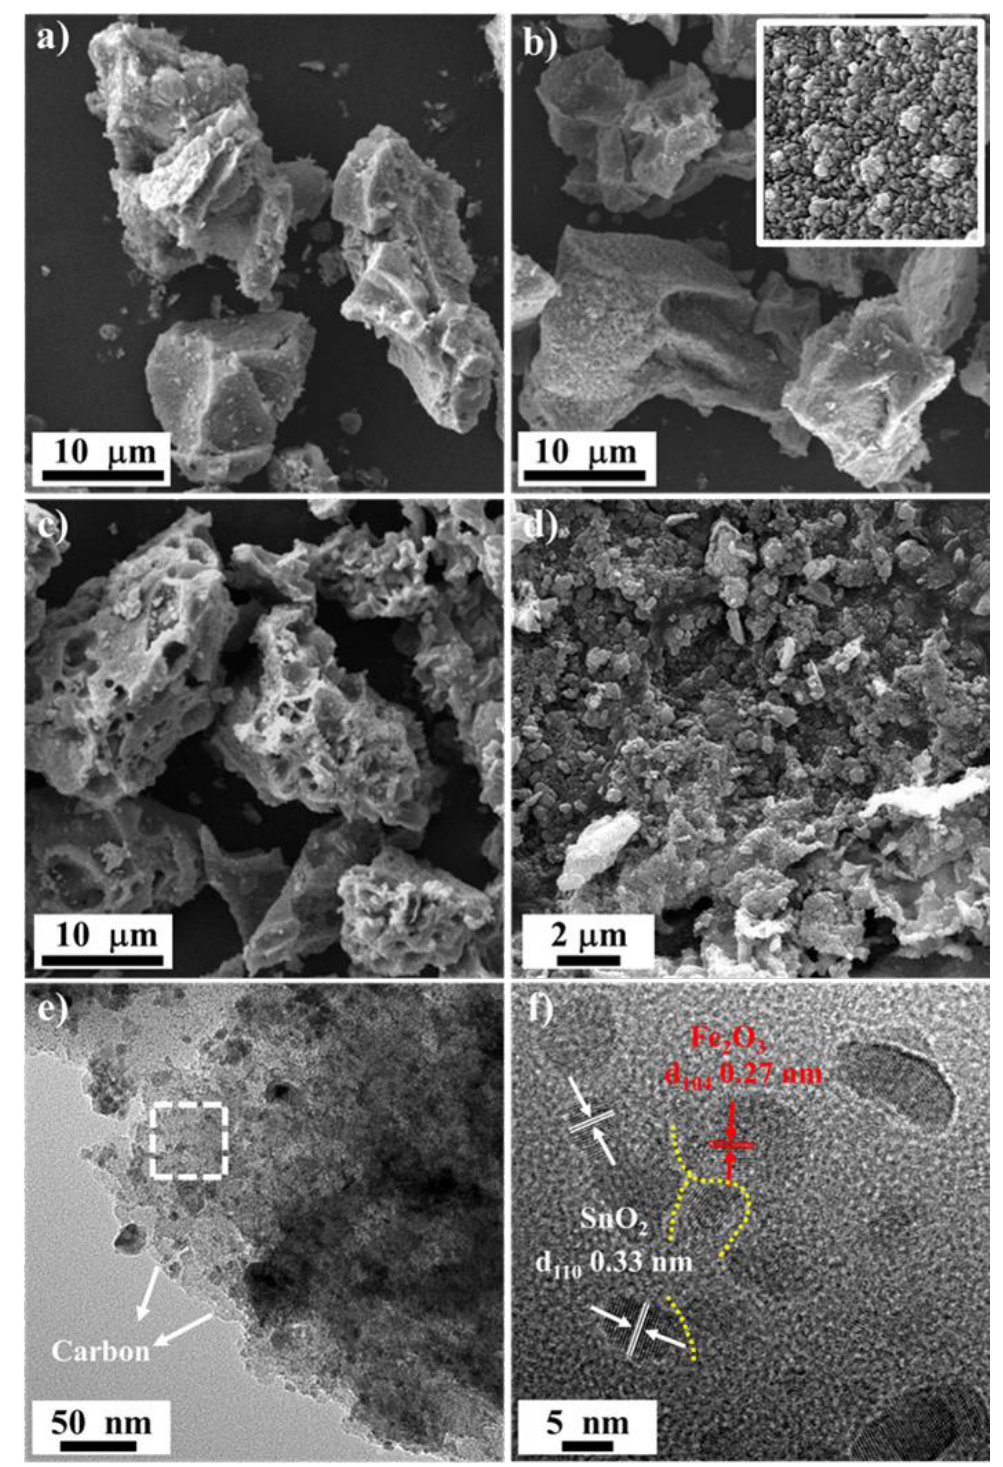
Figure 2. ( a ) SEM images of (a) SFO@C-350, ( b ) SFO@C-400, ( c ) SFO@C-450, and ( d ) SFO samples; ( e ) Figure 2. (a) SEM images of (a) SFO@C-350, (b) SFO@C-400, (c) SFO@C-450, and (d) SFO samples; (e) 302 TEM images of SFO@C-400 sample and ( f ) corresponding HRTEM TEM images of SFO@C-400 sample and (f) corresponding HRTEM image. 303